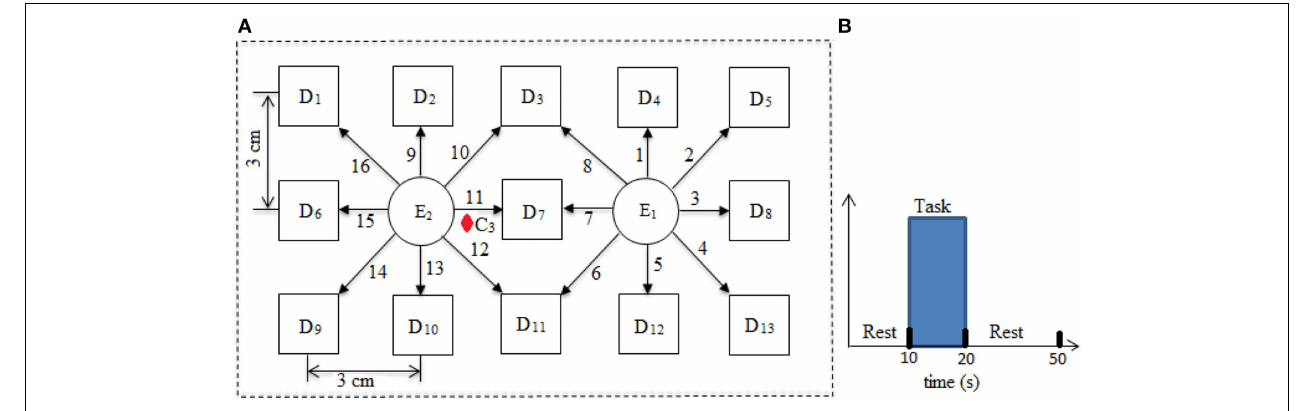
FIGURE 1 | Source/detector locations and distribution of channels (A) and experimental paradigm (B).